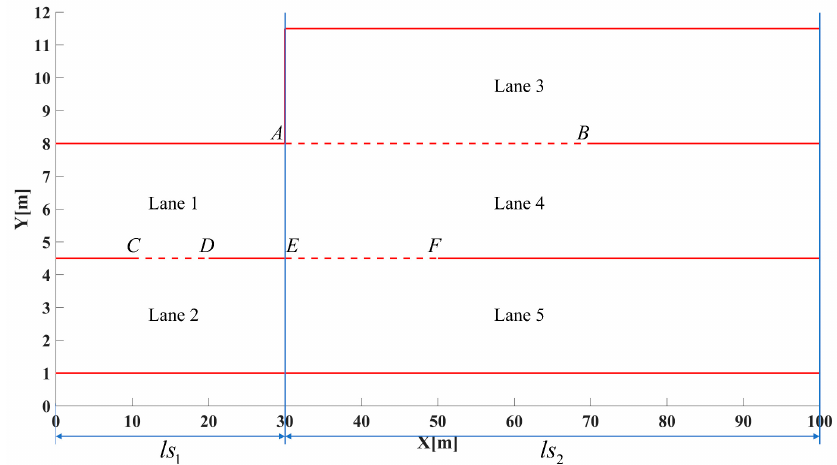
Figure 13. The road had two lane sections, ls 1 and ls 2 , containing two and three lanes numbered from 1 to 5. A–F are attribute control points stored in the point layer, and the dotted line between the two points indicates that lane changes are allowed.